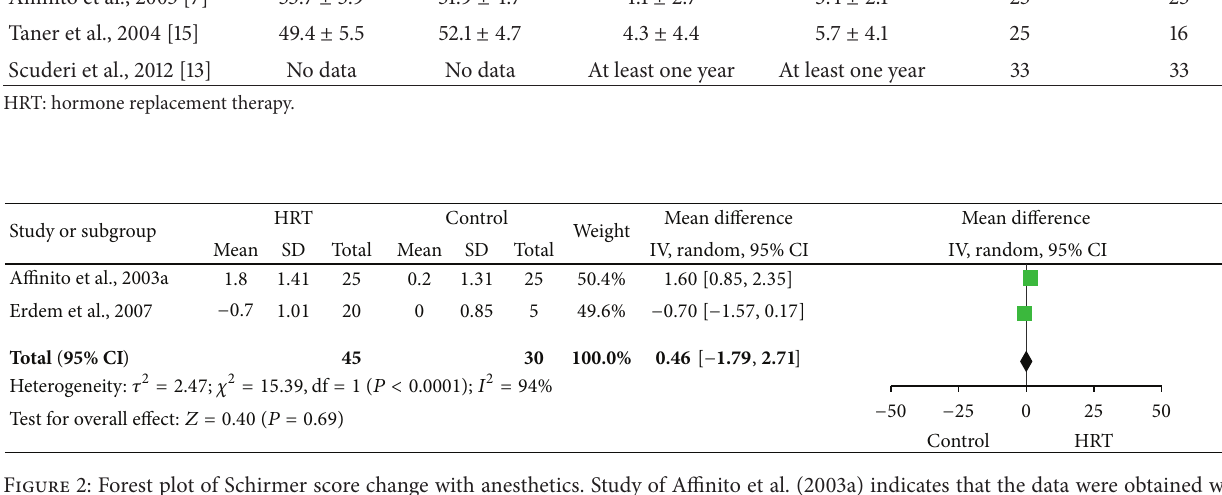
final input for the meta-analysis was the difference value